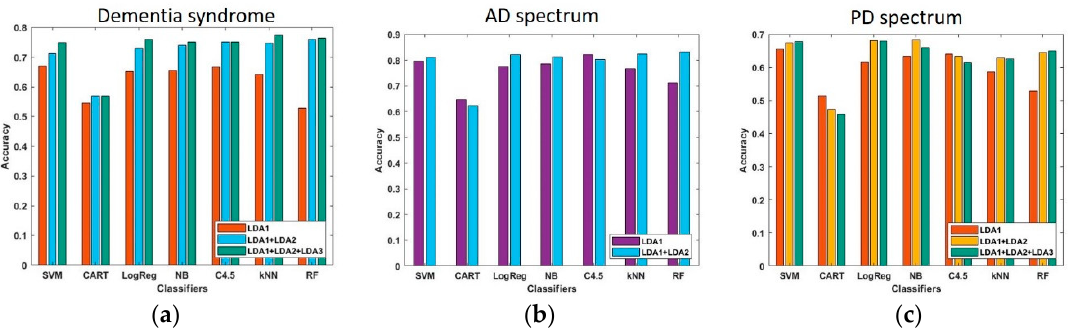
Figure 8. The estimated accuracy for models classifying different dementia syndrome ( a ), AD spectrum ( b ), and PD spectrum ( c ). LDA1: the first function of the linear combinations based on the original five biomarker features using linear discriminant analysis; LDA2: the second function of the linear combinations based on the original five biomarker features using linear discriminant analysis; LDA3: the third function of the linear combinations based on the original five biomarker features using linear discriminant analysis.